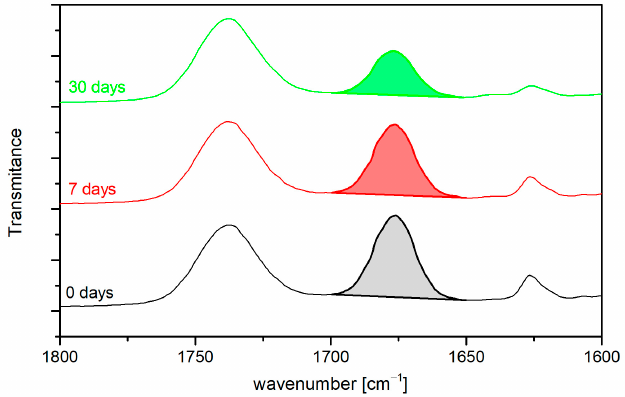
Figure 9. Analysis of peak area changes at 1700 cm − 1 –1650 cm − 1 of the PVC 50ES 20CO sample as a function of migration time (0, 7, and 30 days). Table 4. Migration of active substances to the